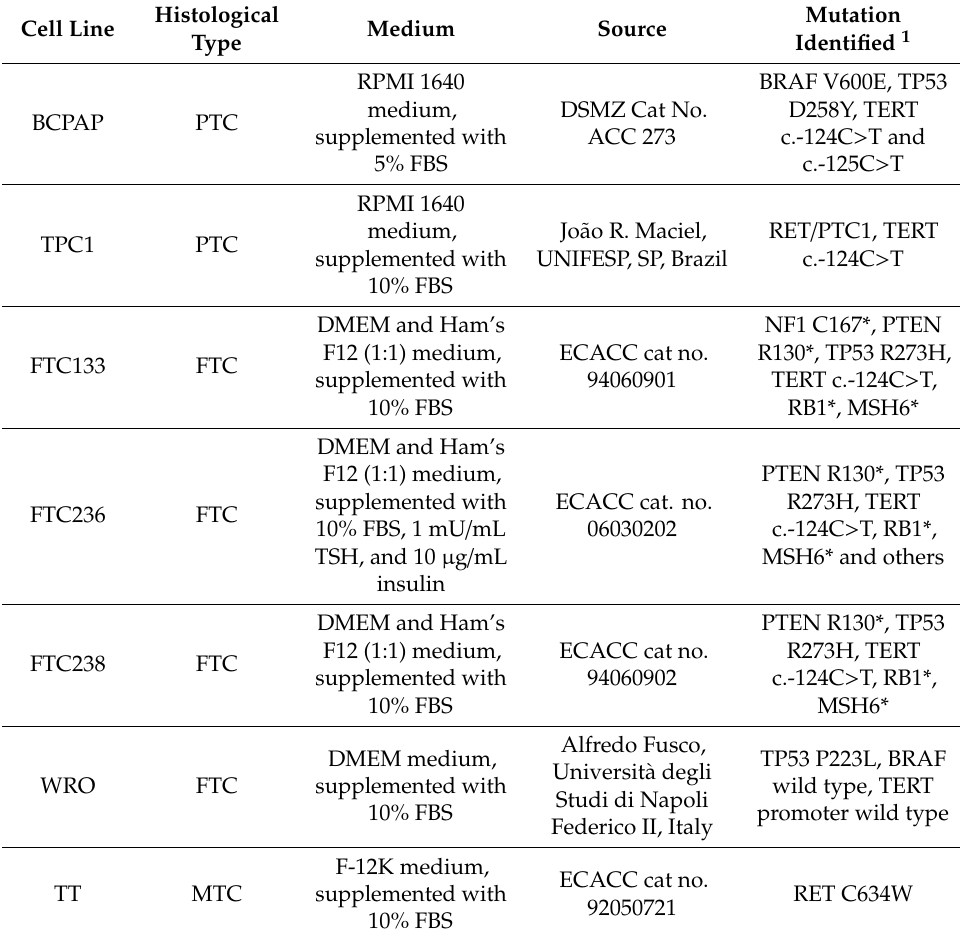
Table 1. Thyroid carcinoma cell lines used in this